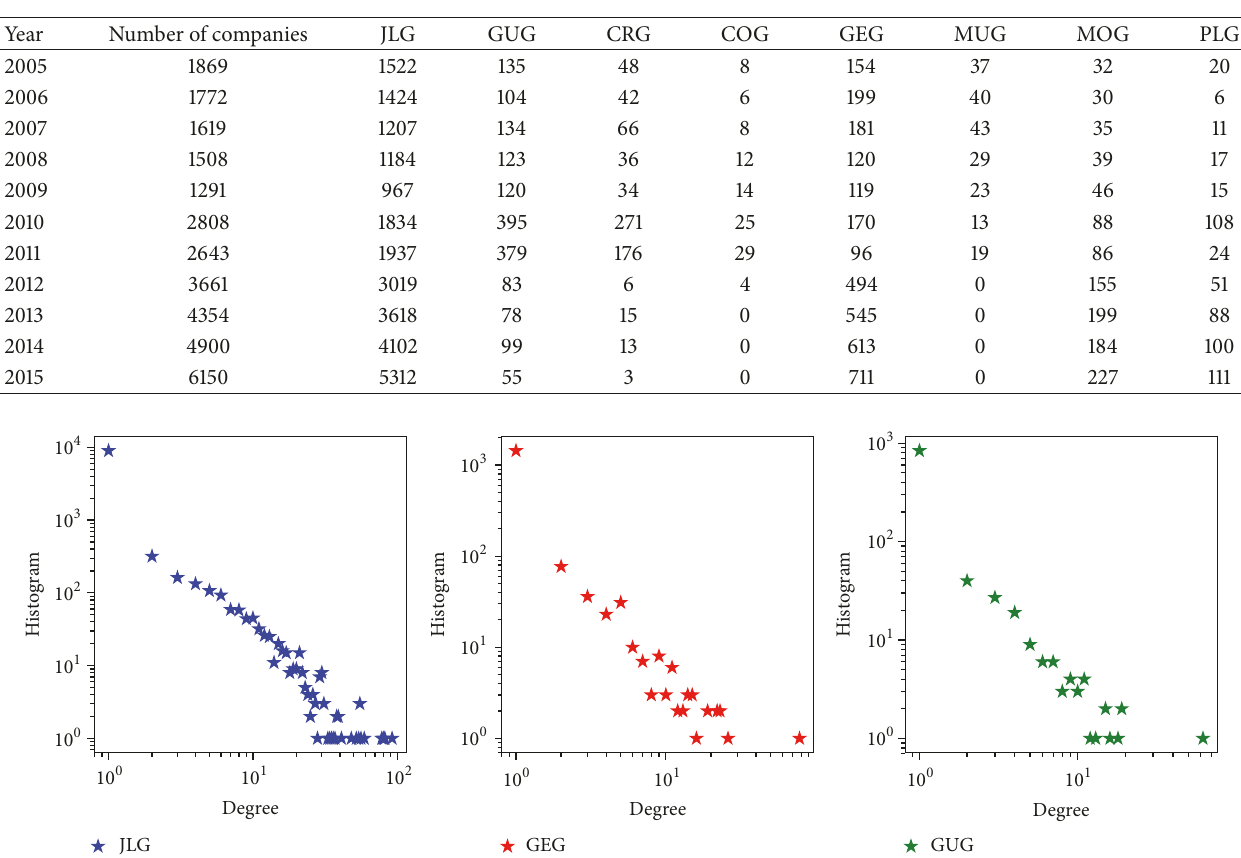
Table 1: Numbers of companies and guarantee relationships from 2005 to 2015.